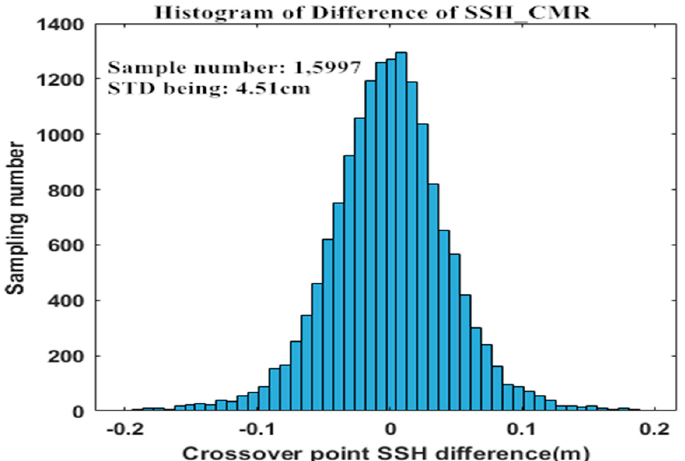
Figure 7. SSH differences histogram of crossover points for HY-2C using CMR_WTC.